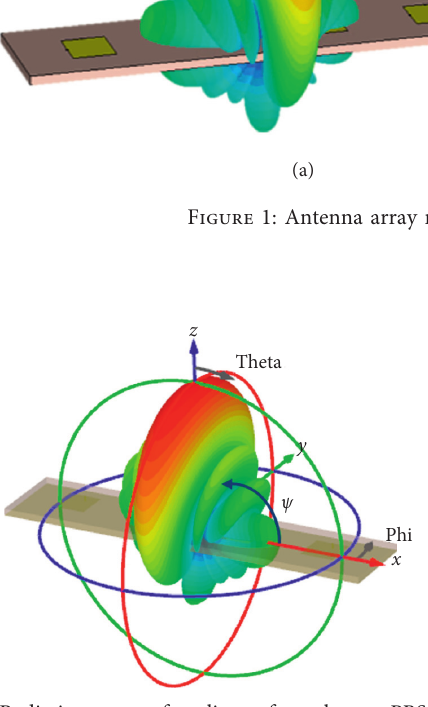
Figure 2: Radiation pattern for a linear, four-element PBS array for beam ψ � 90 ° to indicate the angles θ , φ , and ψ .